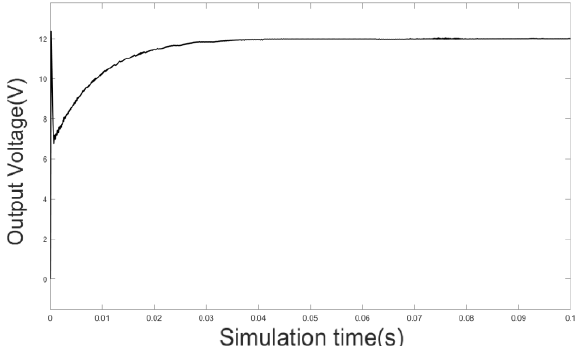
Figure 17. Voltage waveform of system simulation output.